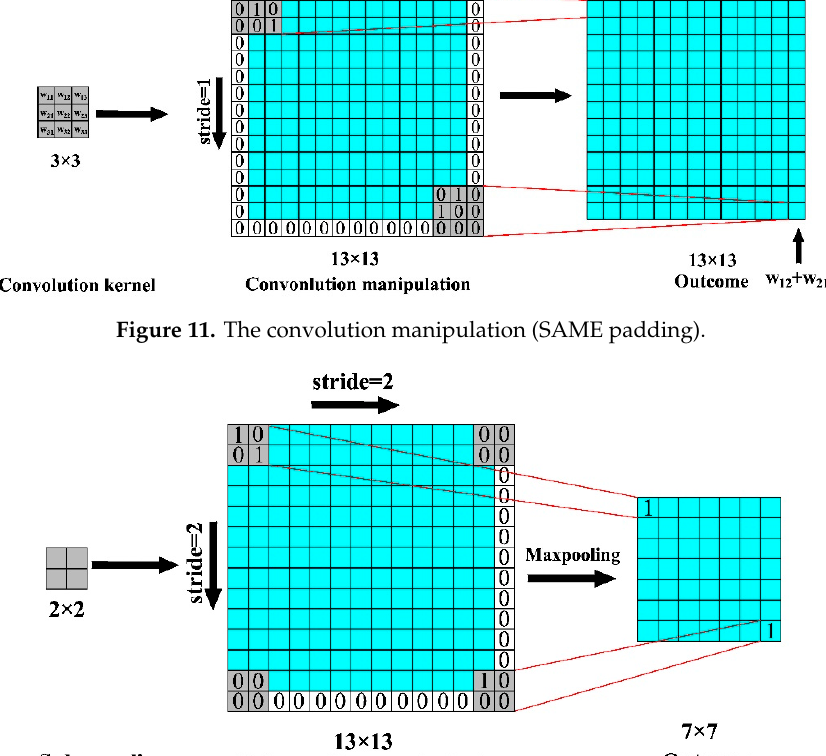
Figure 12. The subsampling manipulation (SAME padding).